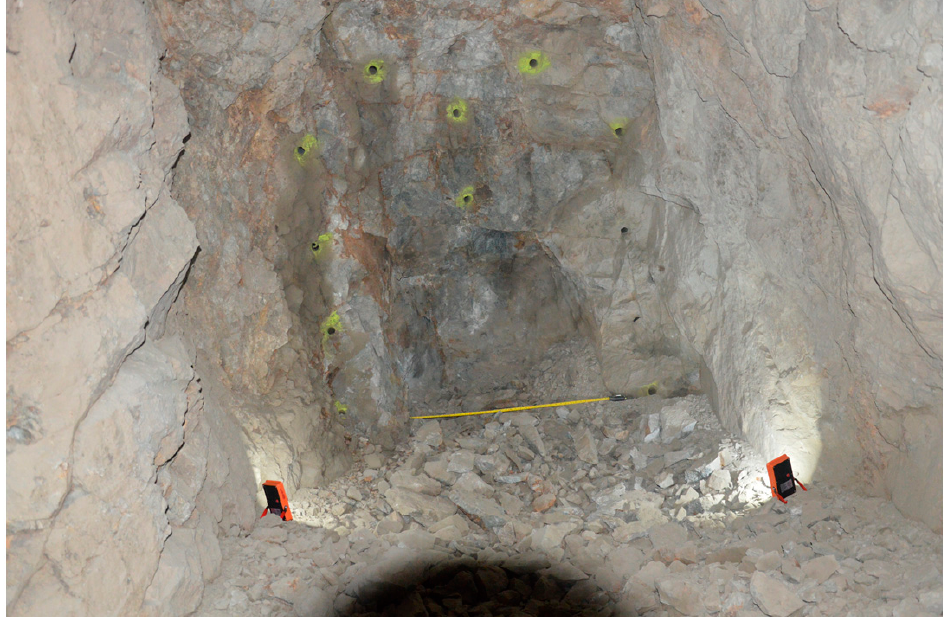
Figure A10. Cavity after detonation of hole with sequence number 9.